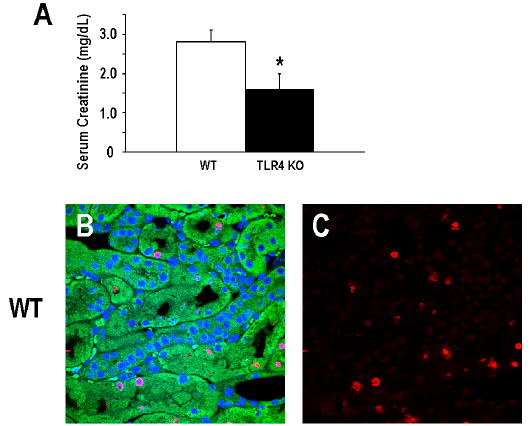
Figure 1. Cont. Figure 1.